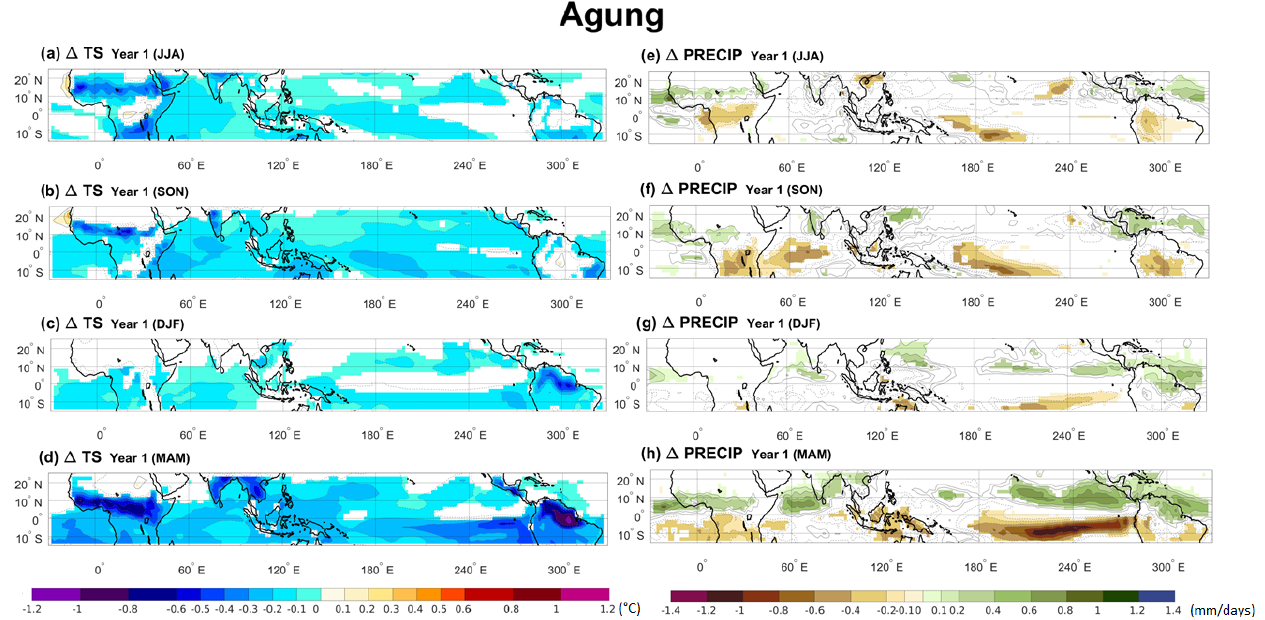
Figure A3. Ensemble mean of changes in surface temperature (a, b, c, d) and precipitation (e, f, g, h) between the climatology and the volcano case for each season of the year after the Agung eruption. Only significant anomalies are shown with an approximate 95% confidence level using Student’s t test. Contours show temperature and precipitation anomalies following the colour bar scale (solid line for positive anomalies and dashed line for negative anomalies).